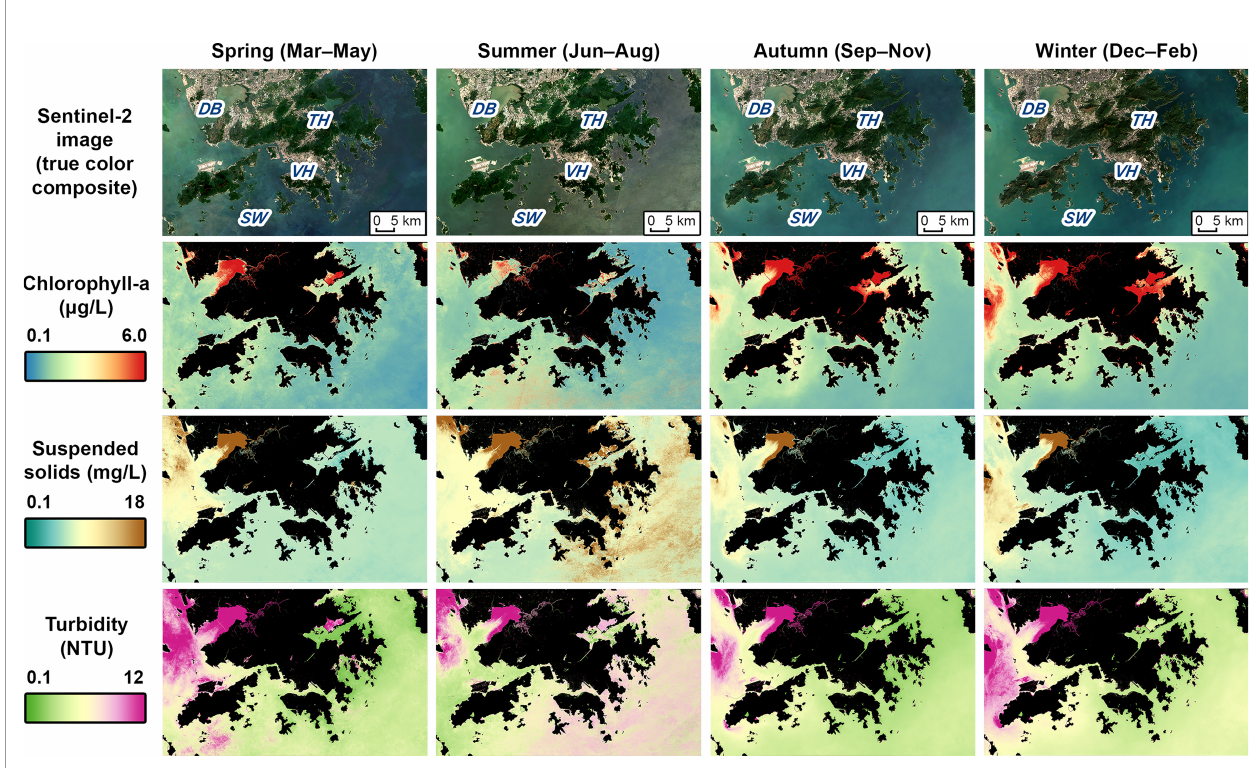
FIGURE 5 | Spatial distribution maps of chlorophyll-a concentration, suspended solids and turbidity in Hong Kong water in the four seasons, calculated as the mean value of all remote sensing-based estimations within each meteorological season in 2015 – 2021. (DB, Deep Bay; VH, Victoria Harbour; TH, Tolo Harbour; SW, Southern